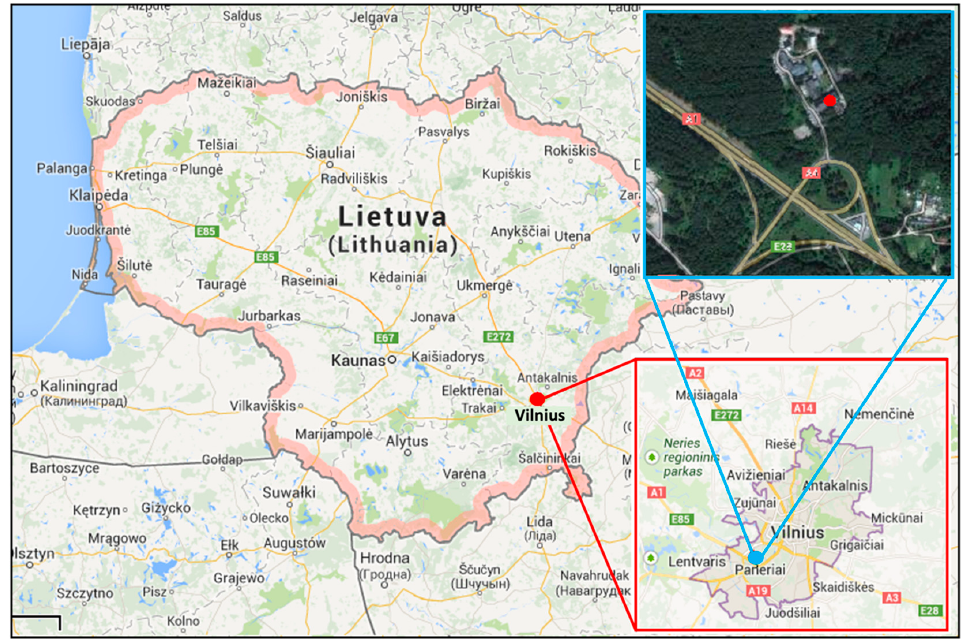
Figure 1. Map of the observation site in Vilnius (indicated by the red marker) (source of maps: free within www.maps.lt (accessed on 10 December 2022)).